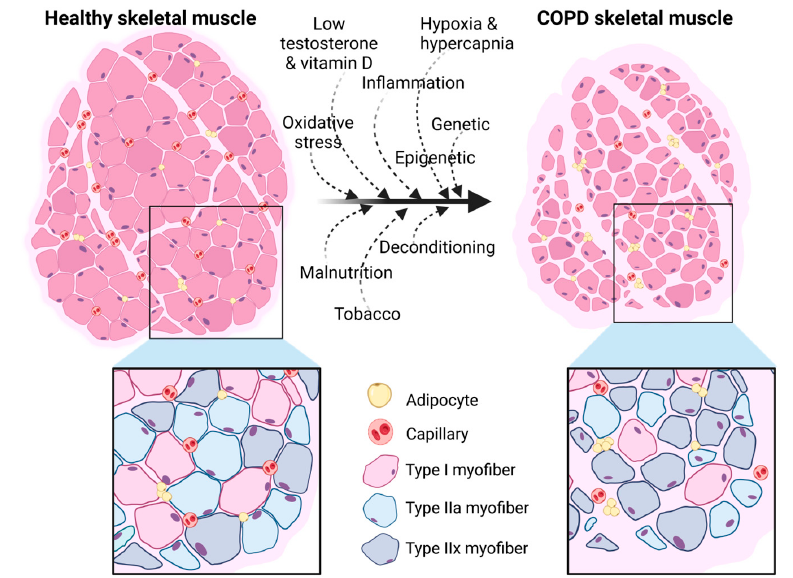
Figure 1. Schematic representation of the main histopathological alterations in COPD skeletal muscle. Alterations of skeletal muscle tissue in COPD result from both extrinsic factors (malnutrition, tobacco exposure, deconditioning) and intrinsic factors (hormonal imbalance, oxidative stress, inflammation, hypoxia and hypercapnia, and genetic and epigenetic modifications). Created with BioRender.com (accessed on 1 February 2023).